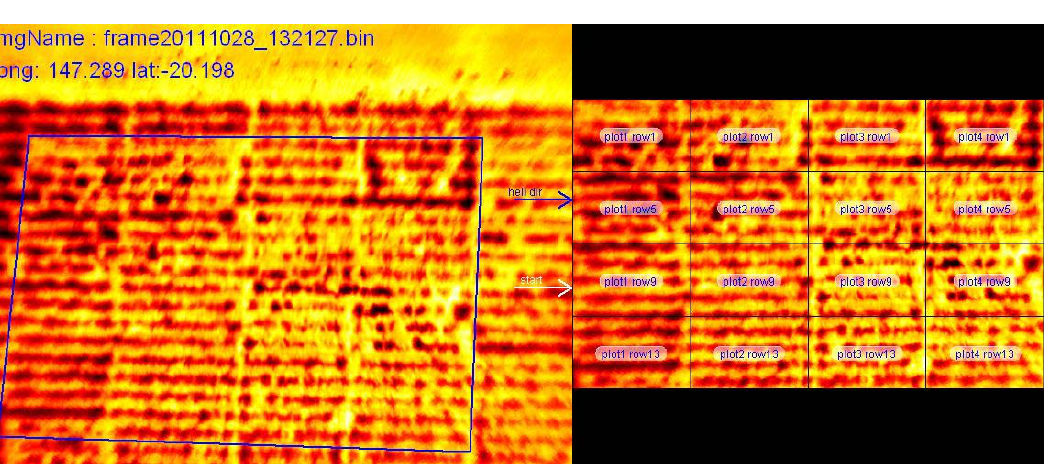
Figure 11. An example of a check image from the plot extraction software. An overlay of the user-selected rectangle on the lens-corrected false-colour thermal image of a sugarcane experiment is seen on the left , with the 16 extracted, straightened and trimmed plot images shown on the right , together with their plot (column) and row positions in the trial